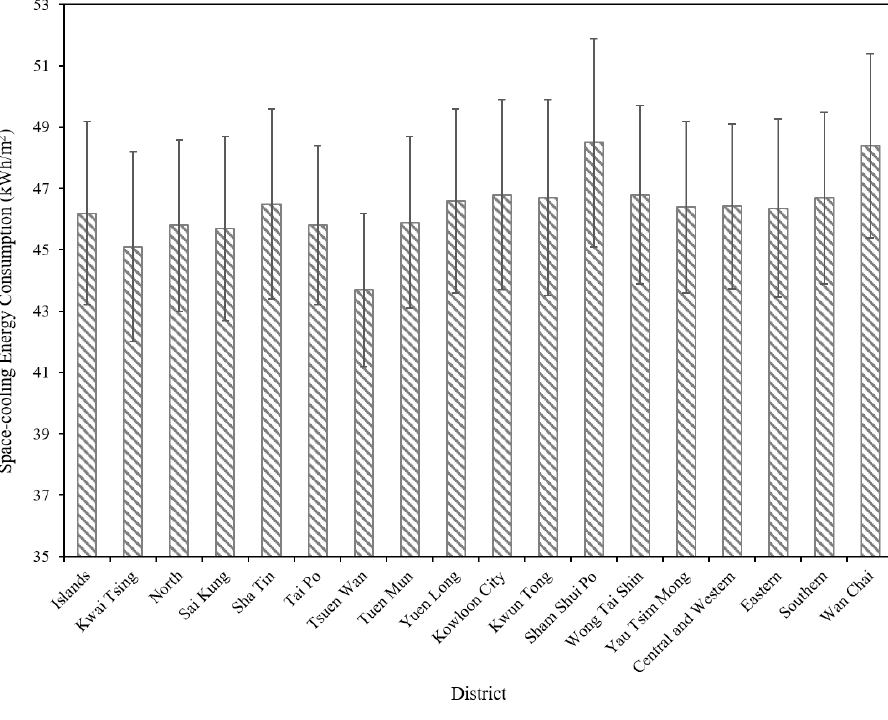
Figure 6. The space-cooling energy consumption for Archetype 5 under different microclimates, averaged over the pensioner and family results. The error bars indicate ±1 standard deviation.